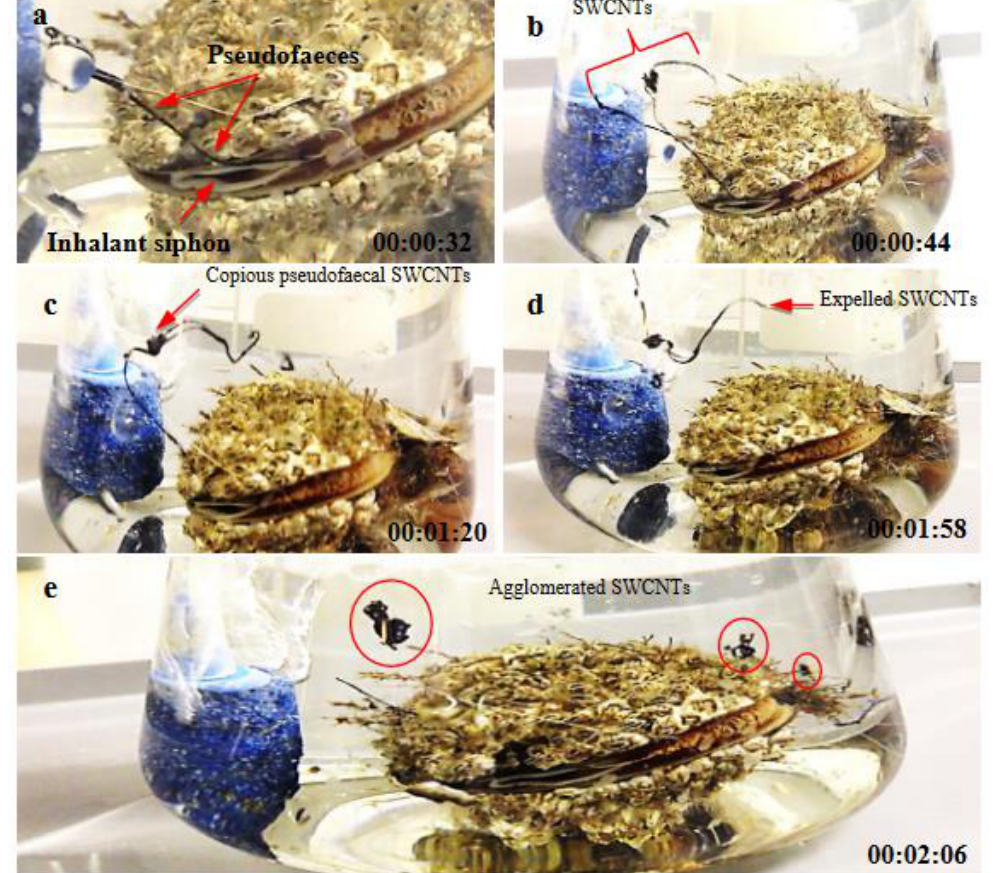
Figure 9. Feeding behavior of mussels when fed SWCNTs + algae: ( a ) mussel starts to expel SWCNTs; ( b , c ) long black nanotubes still attached to the inhalant siphon of mussel; and ( d , e ) SWCNTs have become agglomerated or aggregated in seawater.